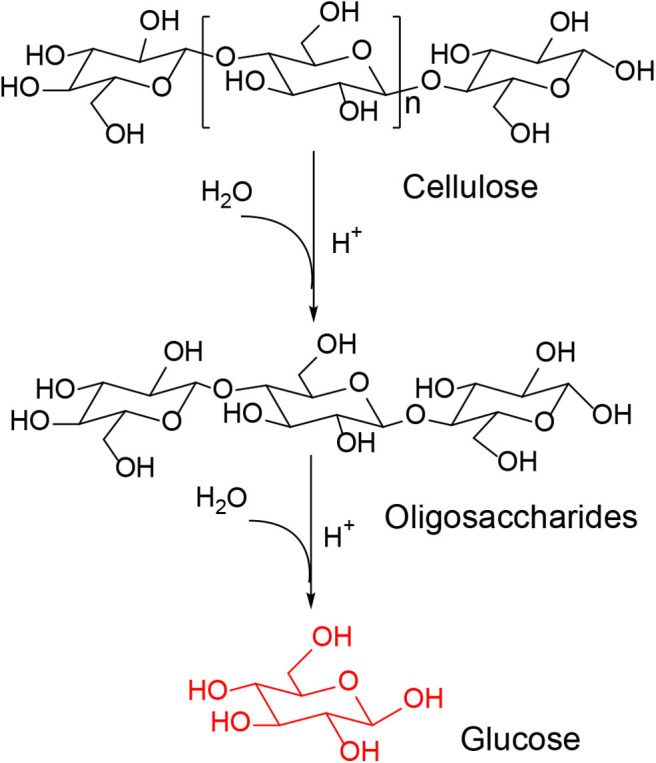
The pathways of cellulose hydrolysis into glucose over CsxH3−xPW12O40.